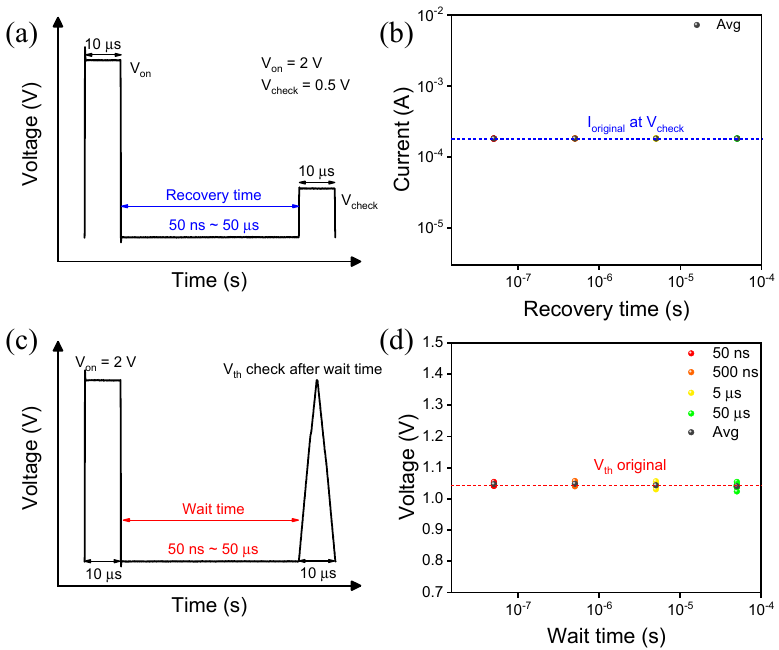
Figure 6. Recovery characteristics of the TiN/NbO x /TiN device: ( a ) pulse and ( b ) recovery time. Drift characteristics of the TiN/NbO x /TiN device: ( c ) pulse and ( b ) drift-free.